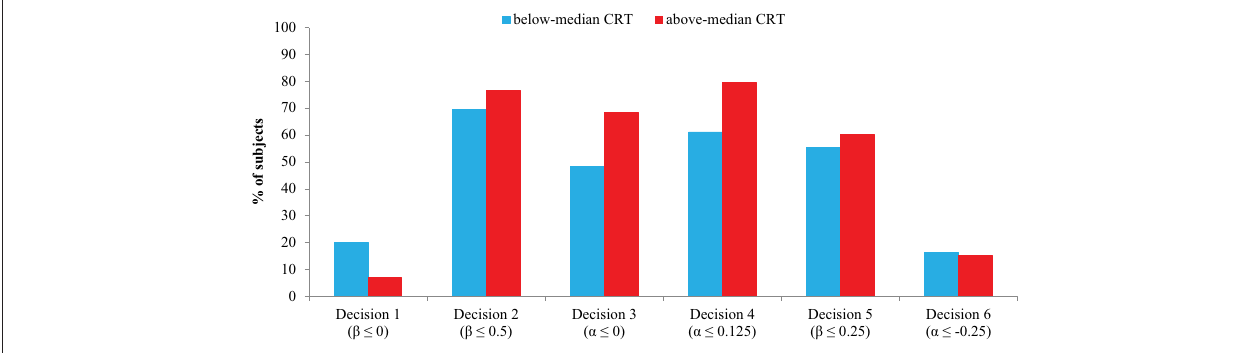
FIGURE 4 | Percentage of subjects choosing option B in each decision, by CRT groups (Study 2). The model parameters associated to option B are shown in